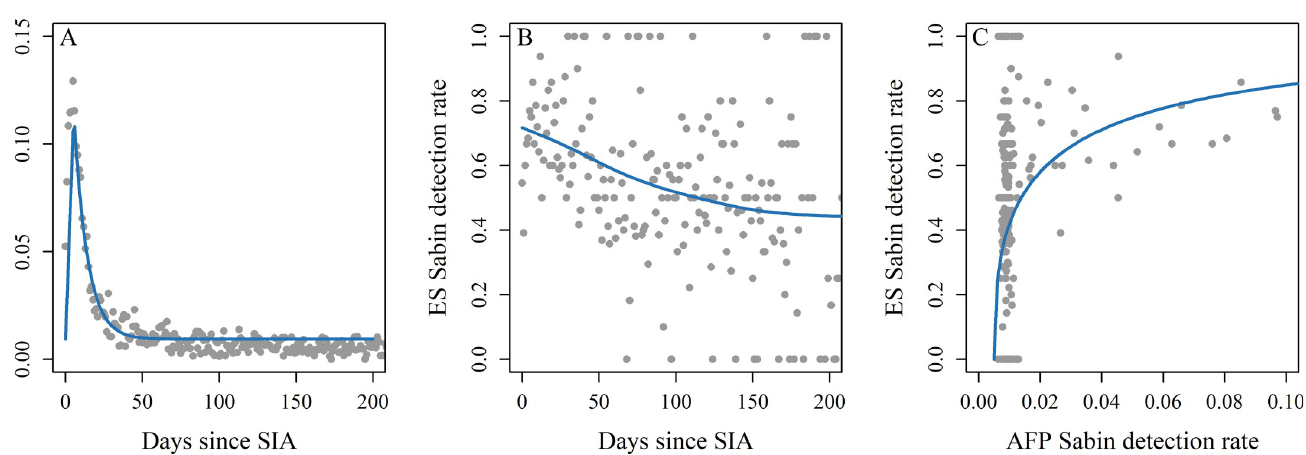
PLOS ONE | https://doi.org/10.1371/journal.pone.0208336 December28,